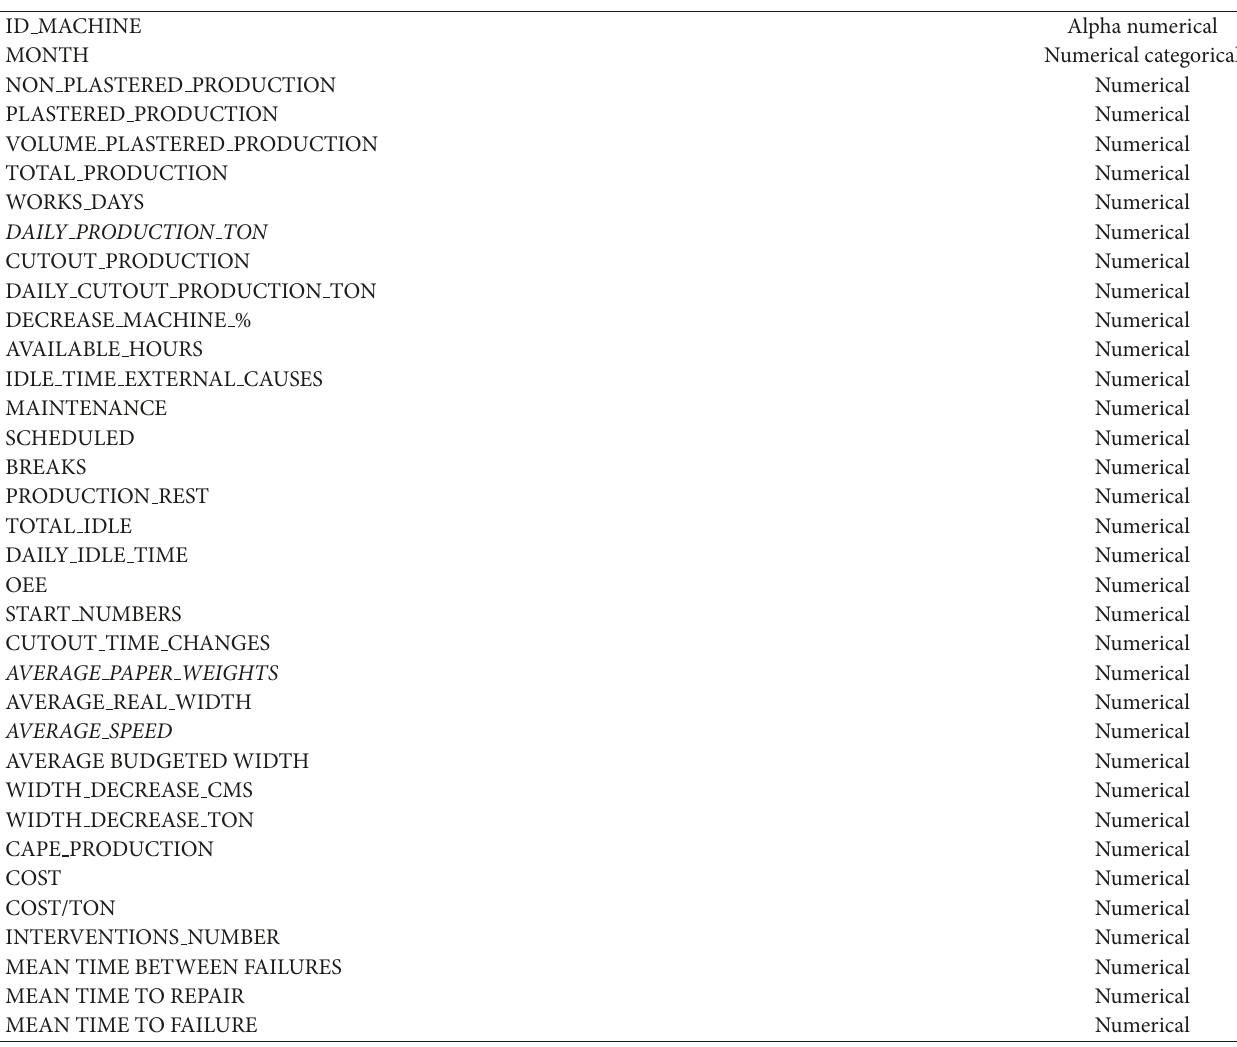
Table 2: Original attributes of the manufacturing report (production